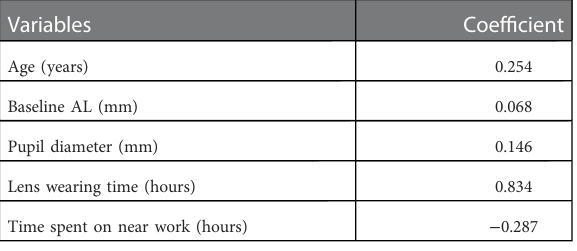
TABLE 2 The LASSO regression selection for ortho-k treatment effect.